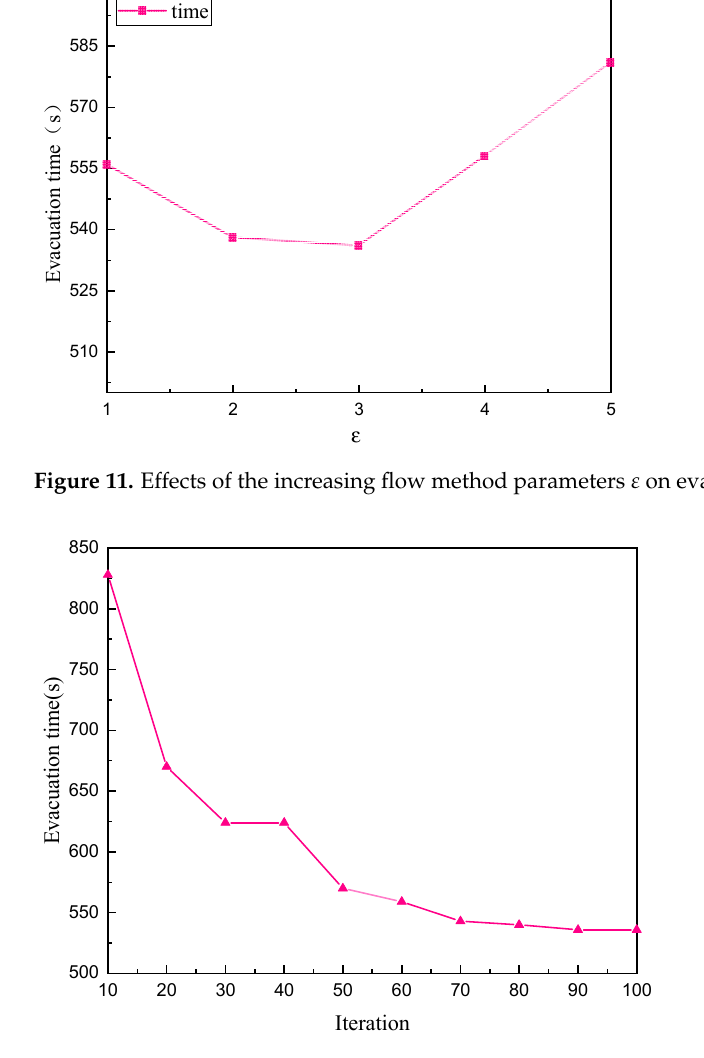
Figure 12. Relationship between the number of iterations and evacuation time.